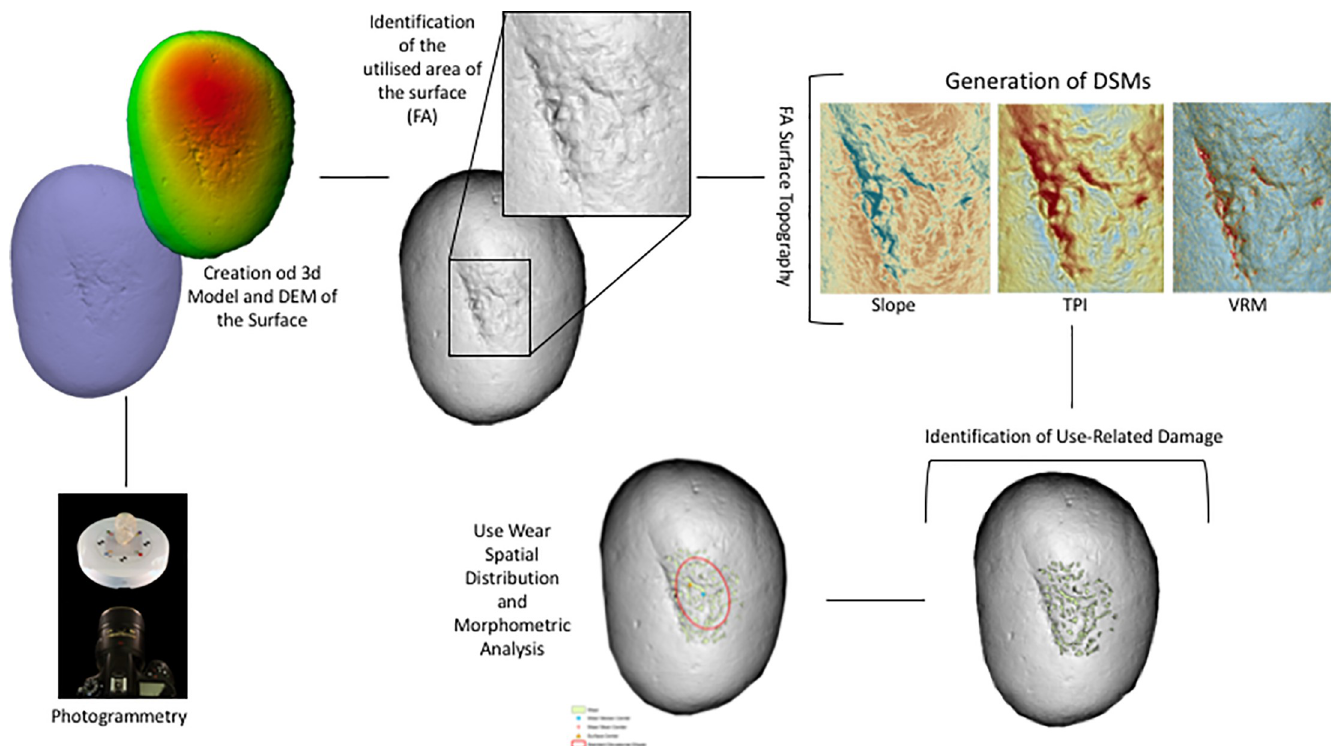
Fig 3. Schematic representation of the methodology applied for the creation of 3D models and the spatial analysis of the utilised areas of the tools.